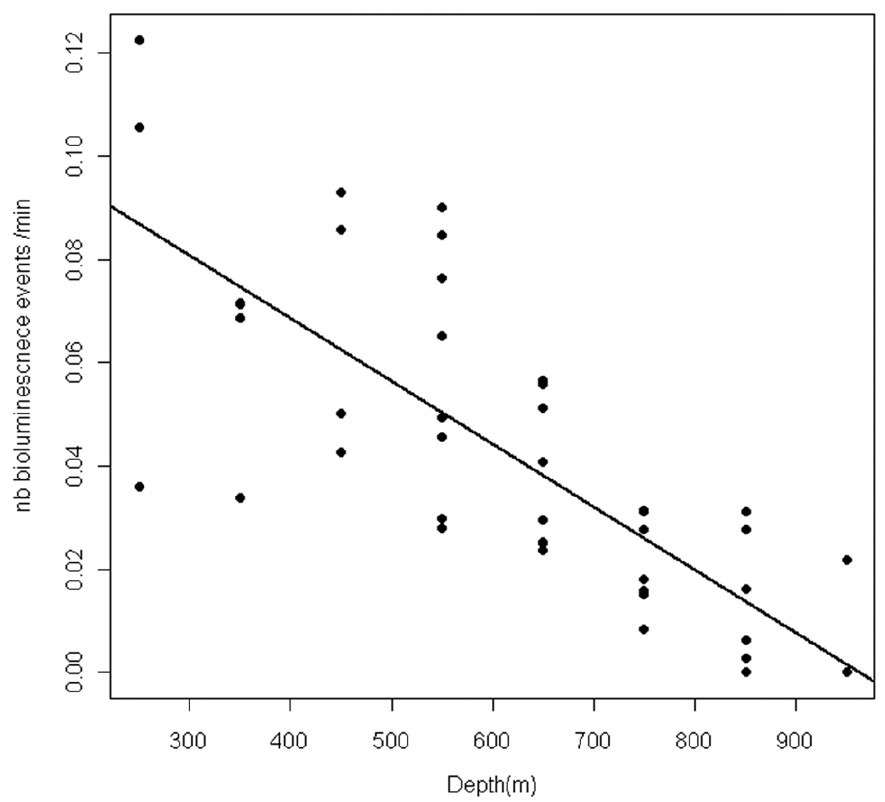
Figure 5. Bioluminescence into the water mass. The graph represents the distribution of the bioluminescence events according to the depth. The number of events was corrected by the time spent by all the individuals in each depth category. The black line shows the linear regression between the number of bioluminescence events per minute and depth.